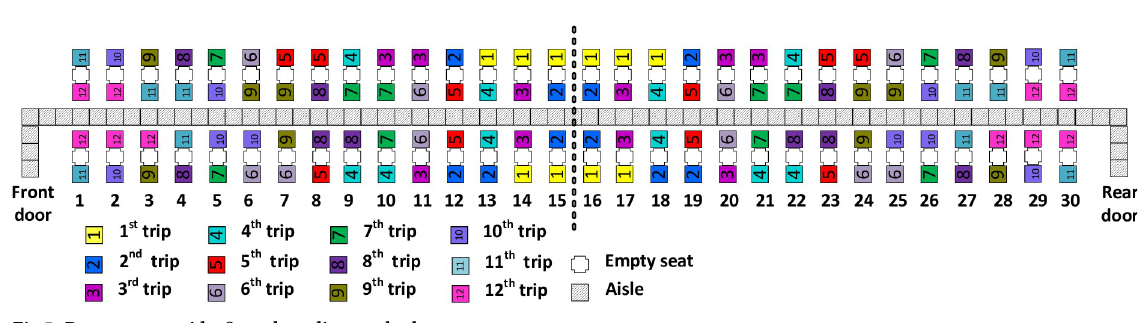
Fig 5. Reverse-pyramid—Steep boarding method.